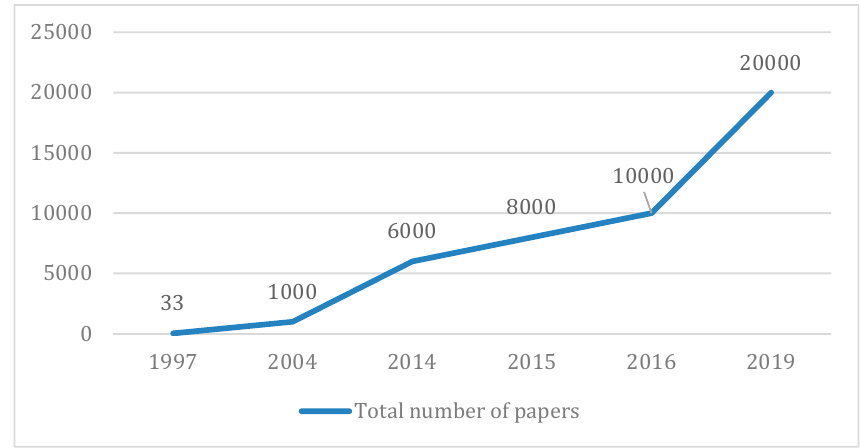
Figure 1. The years some milestone papers were published.